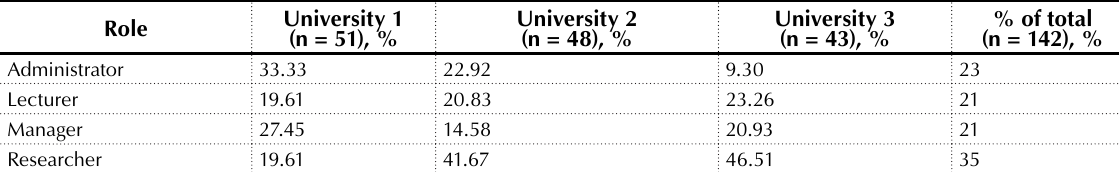
Table 1. Respondents role by